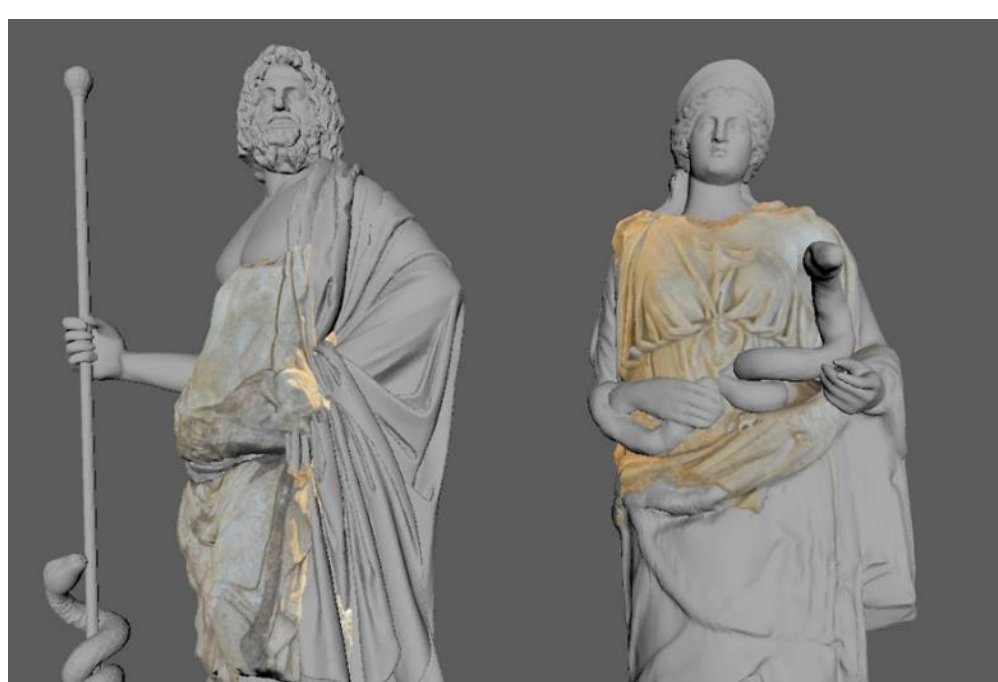
Figure 11. Close-up view of the Aesculapius and Hygeia statues high poly models .